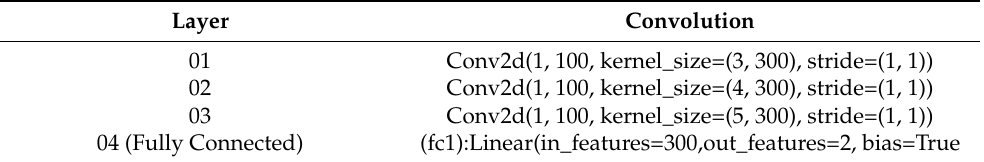
Table 8. Configuration parameters of the CNN classification